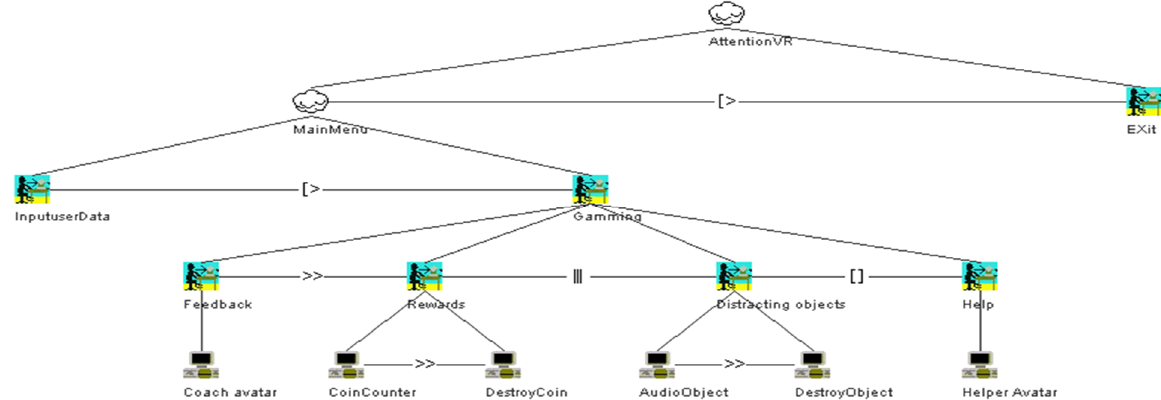
Figure A4. Teachers applying safety protocols such as the use of masks and disinfectant materials.